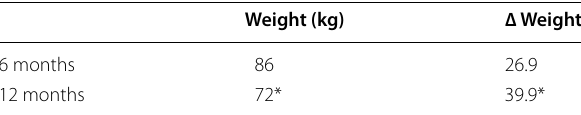
Table 2 Comparing between 6‑ and 12‑month postoperative weight and the ∆ weight in 26 patients